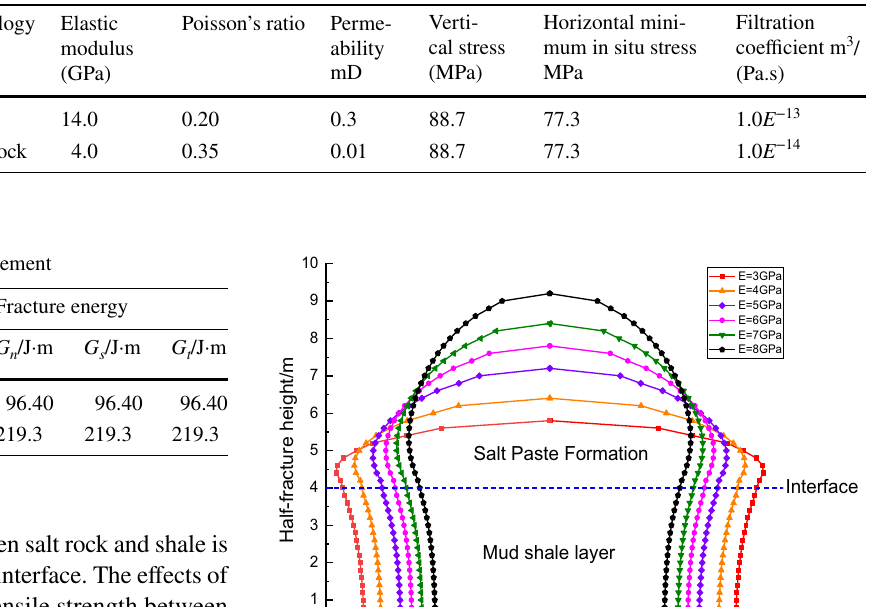
Table 5 The rock mechanical parameters of formation